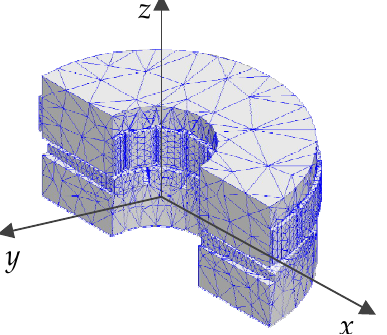
Figure 5. Half-Subdivision of AFPMBLDCM.